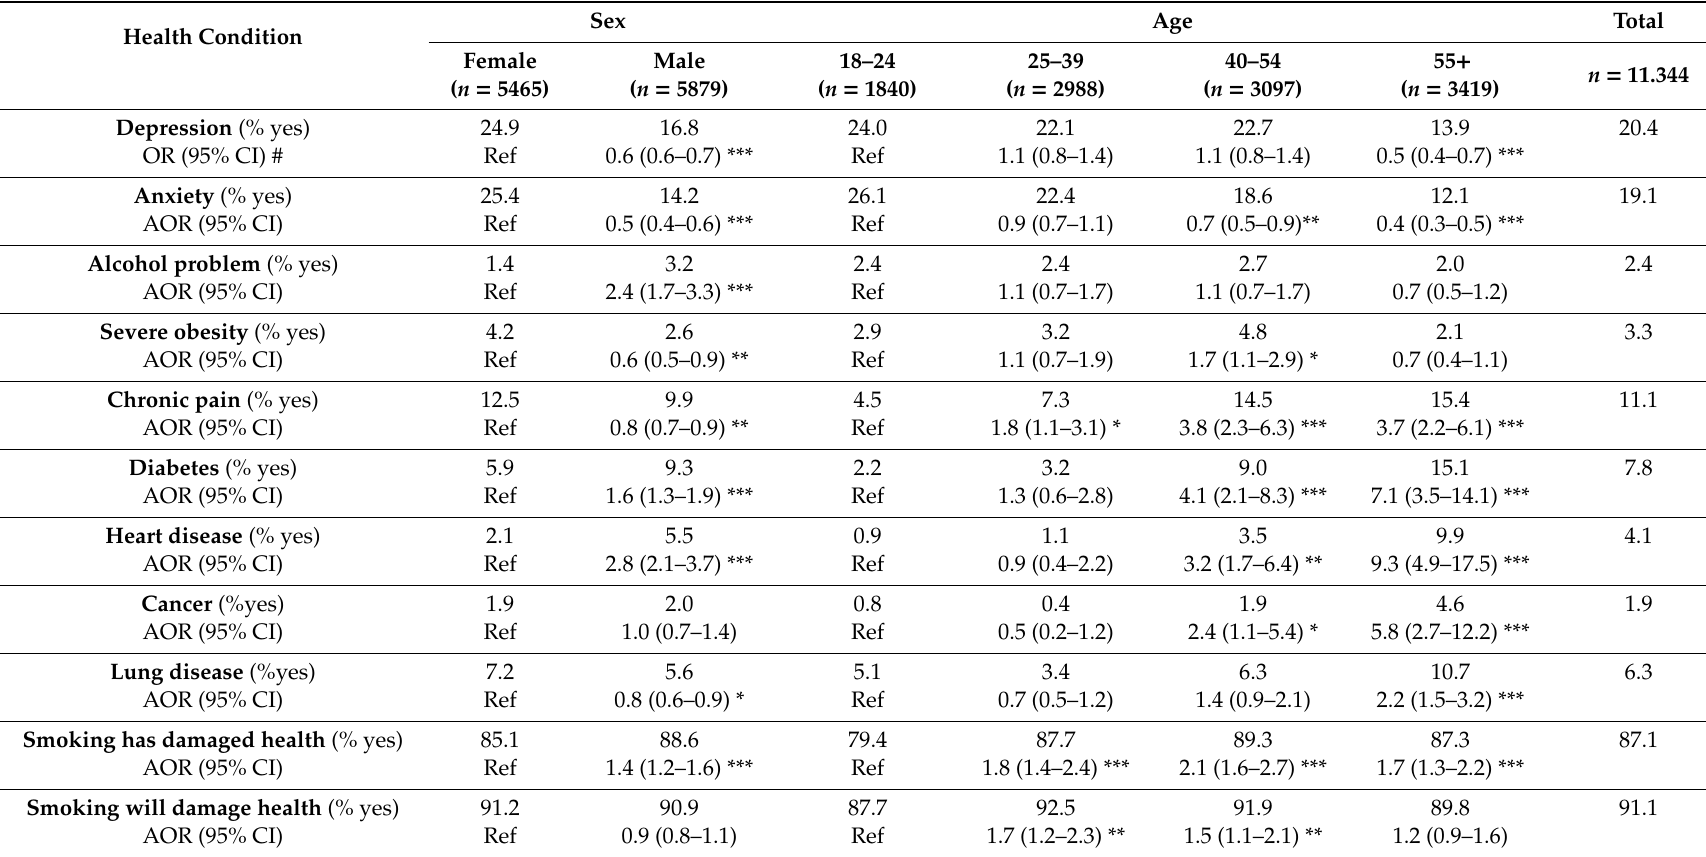
Table 2. Percentages reporting health conditions, by sex and age (total n = 11,344 ˆ),